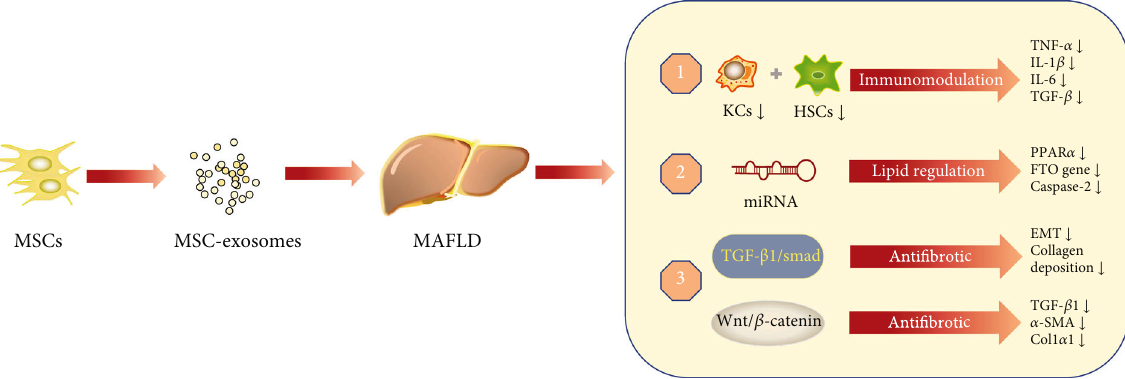
Figure 2: The e ff ects of MSC-exosomes in MAFLD. MSC-exosomes play a role in MAFLD through immunomodulation, lipid regulation, and anti fi brotic. MSCs: mesenchymal stem cells; MSC-exosomes: MSC-derived exosomes; KCs: Kup ff er cells; HSCs: hepatic stellate cells; TNF- α : tumor necrosis factor- α ; IL-1 β : interleukin-1 β ; IL-6: interleukin-6; TGF- β : transforming growth factor- β ; miRNA: microRNA; PPAR α : peroxisome proliferator-activated receptor- α ; FTO gene: fat mass and obesity-related gene; α -SMA: α -smooth muscle actin; Col1 α 1: Collagen 1 α